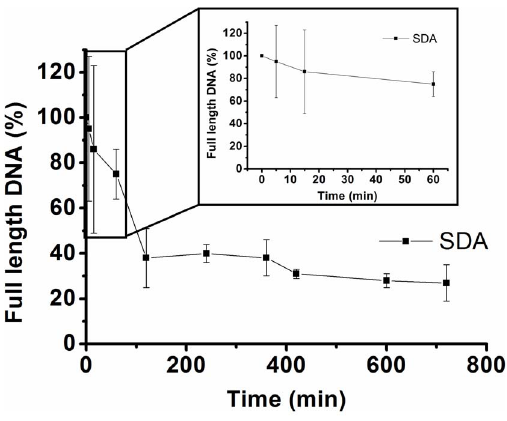
Figure 4. Stability of SDA in cell culture media. Radiolabeled SDA was incubated with full medium and analyzed via polyacrylamide gel electrophoresis. After one hour more than half of SDA was still available (small